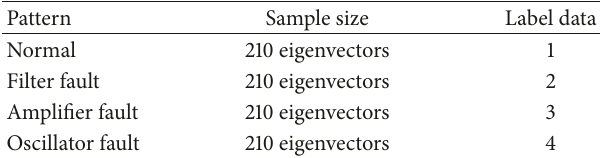
Table 4: Training eigenvectors for fault diagnosis.